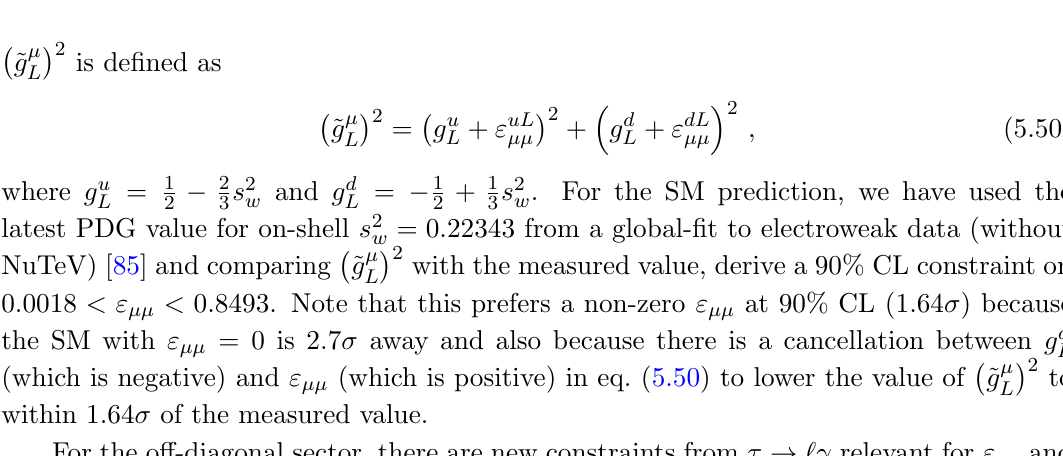
Figure 34 . Neutrino mass generation in the one-loop model with both doublet and triplet LQs. 9 This is the model of table 3 3 O